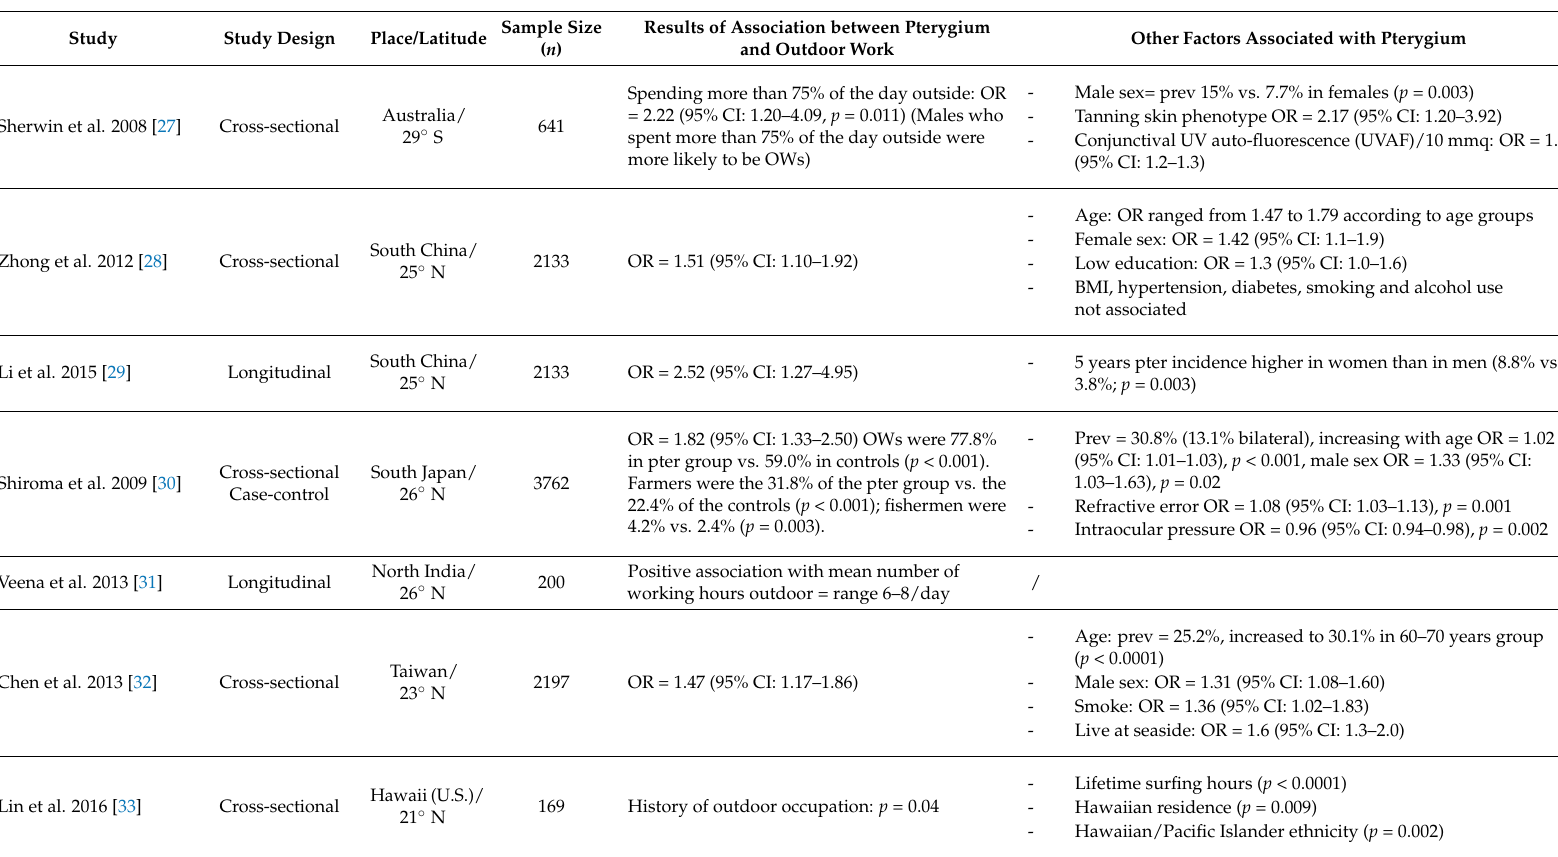
Table 4. Synthesis of the studies on occupational solar UV radiation exposure and pterygium included in the systematic review of scientific literature published in the period 2008–2017 performed in World areas at very high risk considering the mean annual UV index